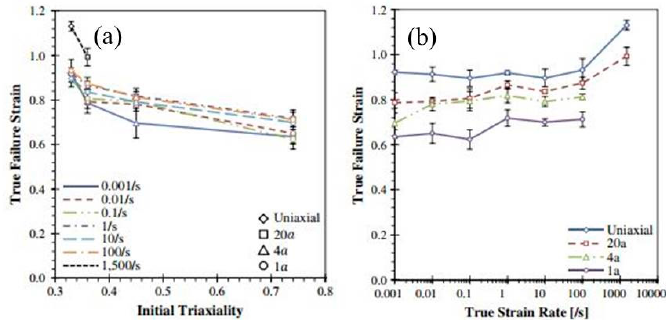
Figure 30. True failure strain as a function of ( a ) stress triaxiality and ( b ) true strain rate [175] .